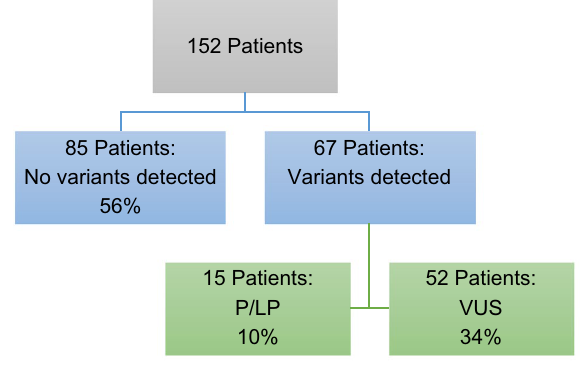
Figure 2. Overall results of gene panel testing. Of note, the VUS rate does not include VUS detected in patients with P/LP variants.